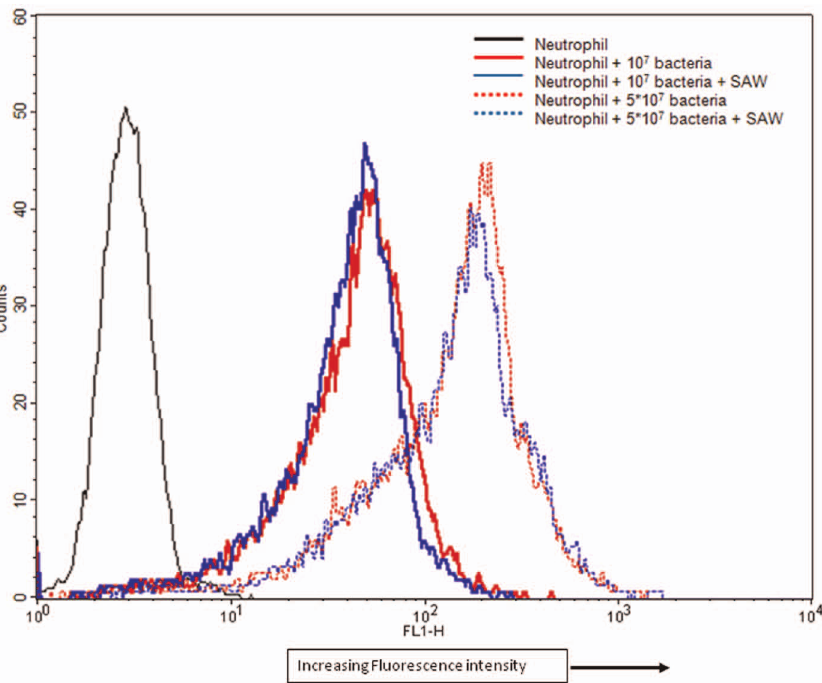
Figure 6. FACS analysis of neutrophil phagocytosis of BCECF-AM labeled S.epidermidis . 10 7 and 5 6 10 7 CFU S. epidermidis were co- embedded with human neutrophils in fibrin gels. After 90 mins the gels were lysed and the neutrophils were recovered and fluorescence intensity was analyzed using a BD FACS Calibur.